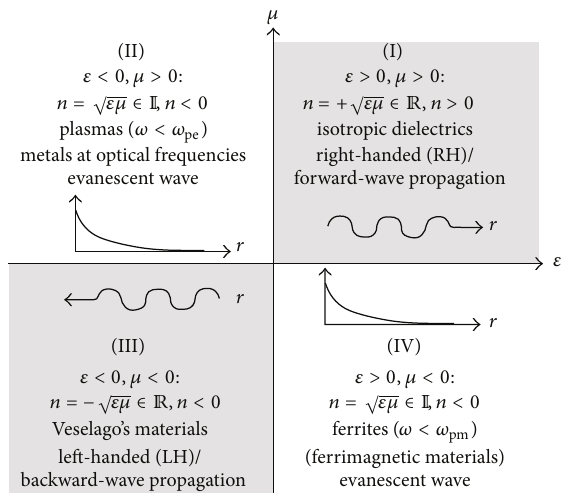
Figure 1: Permittivity, permeability, and refractive index diagram.